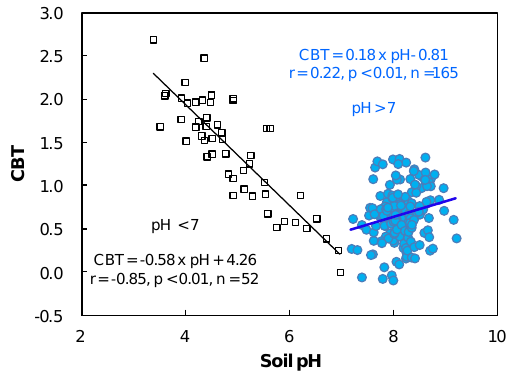
Figure 4. Plot of soil pH vs. CBT for the Chinese alkaline soils used in this study (indicated by blue solid circles), with previously published data from Yang et al. (2012), Xie et al. (2012), and Yang et al. (2014a). Also shown is the correlation between pH and CBT in other Chinese soils with pH<7 (Weijers et al., 2007; Xie et al., 2012; Yang et al., 2012,